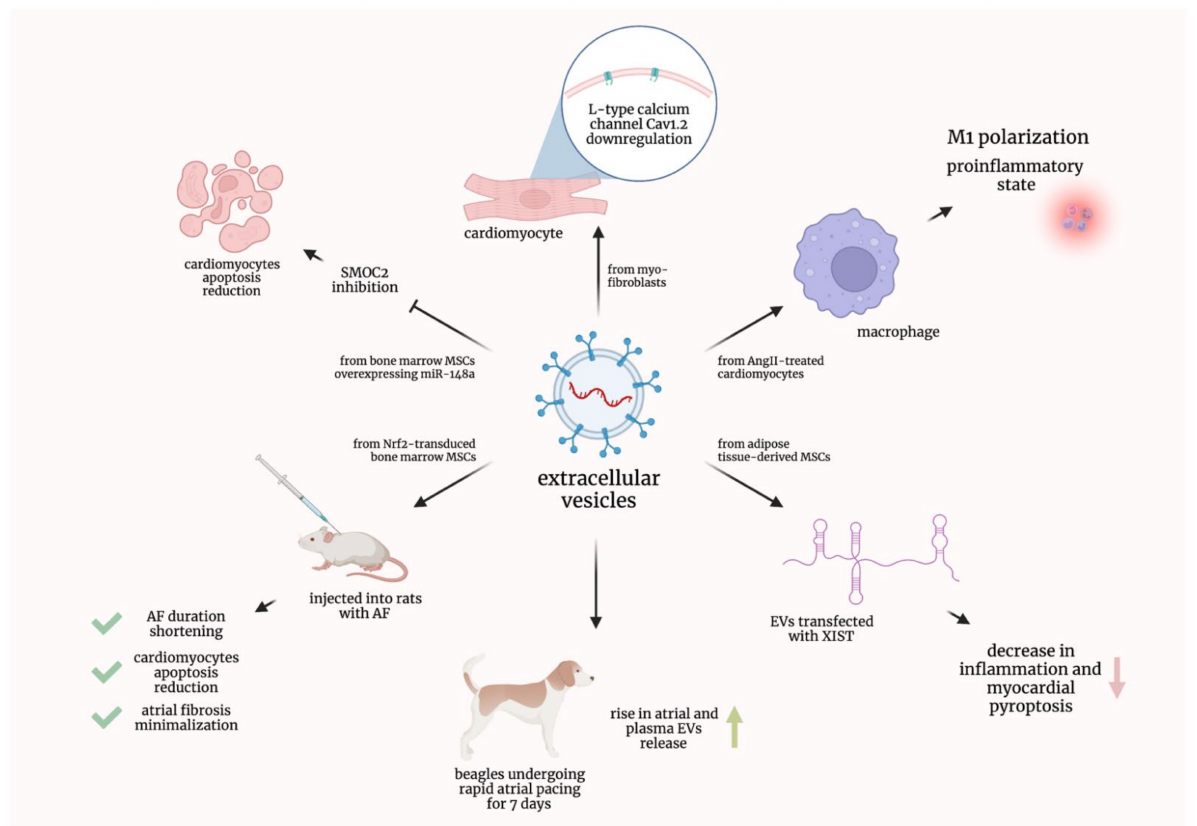
Figure 2. Graphical summarization of the preclinical studies concerning extracellular vesicles in atrial fibrillation. AF—atrial fibrillation; AngII—Angiotensin II; EVs—extracellular vesicles; miR—micro- ribonucleic acid; MSCs—mesenchymal stem cells; Nrf2—nuclear factor-erythroid 2-related factor